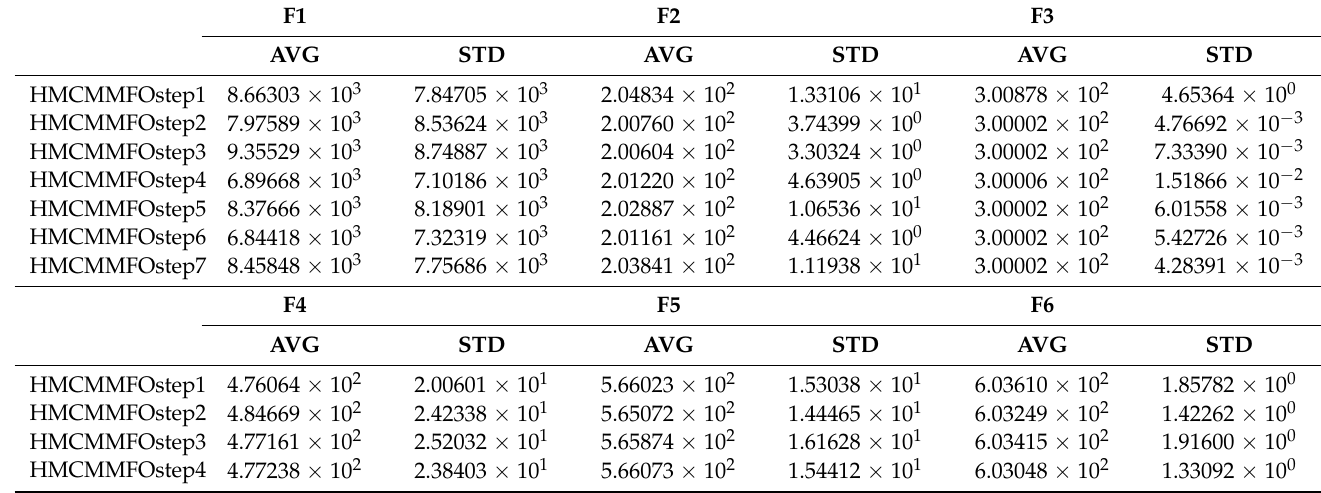
Table 3. Comparison of the results of HMCMMFO using different step